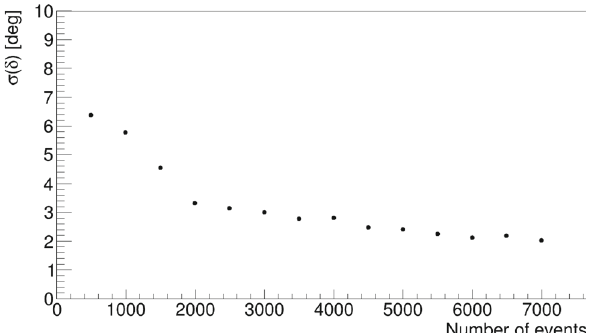
Fig. 14 Uncertainty of the determination the δ parameter defined in Eq. (7) as a function of number of measured events for the J-PET setup shown in Fig 2. It shows that we expect that J-PET will deduce the ‘position’ of the maximum in the contribution with an uncertainty of ± 2 ◦ if the number of events reaches more than 5000 events, but more events will not increase this result